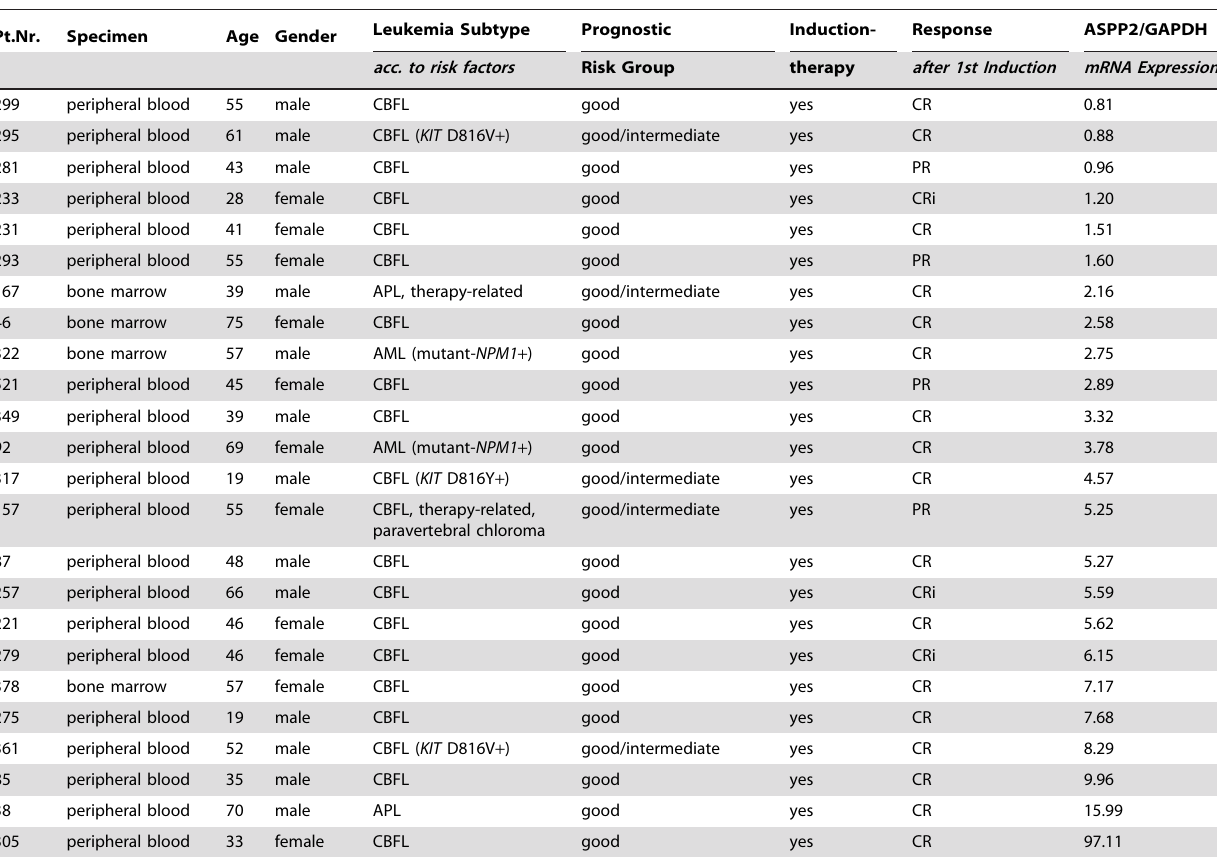
Table 1. Patient Characteristics (mRNA Assay): Good-Risk Cohort.